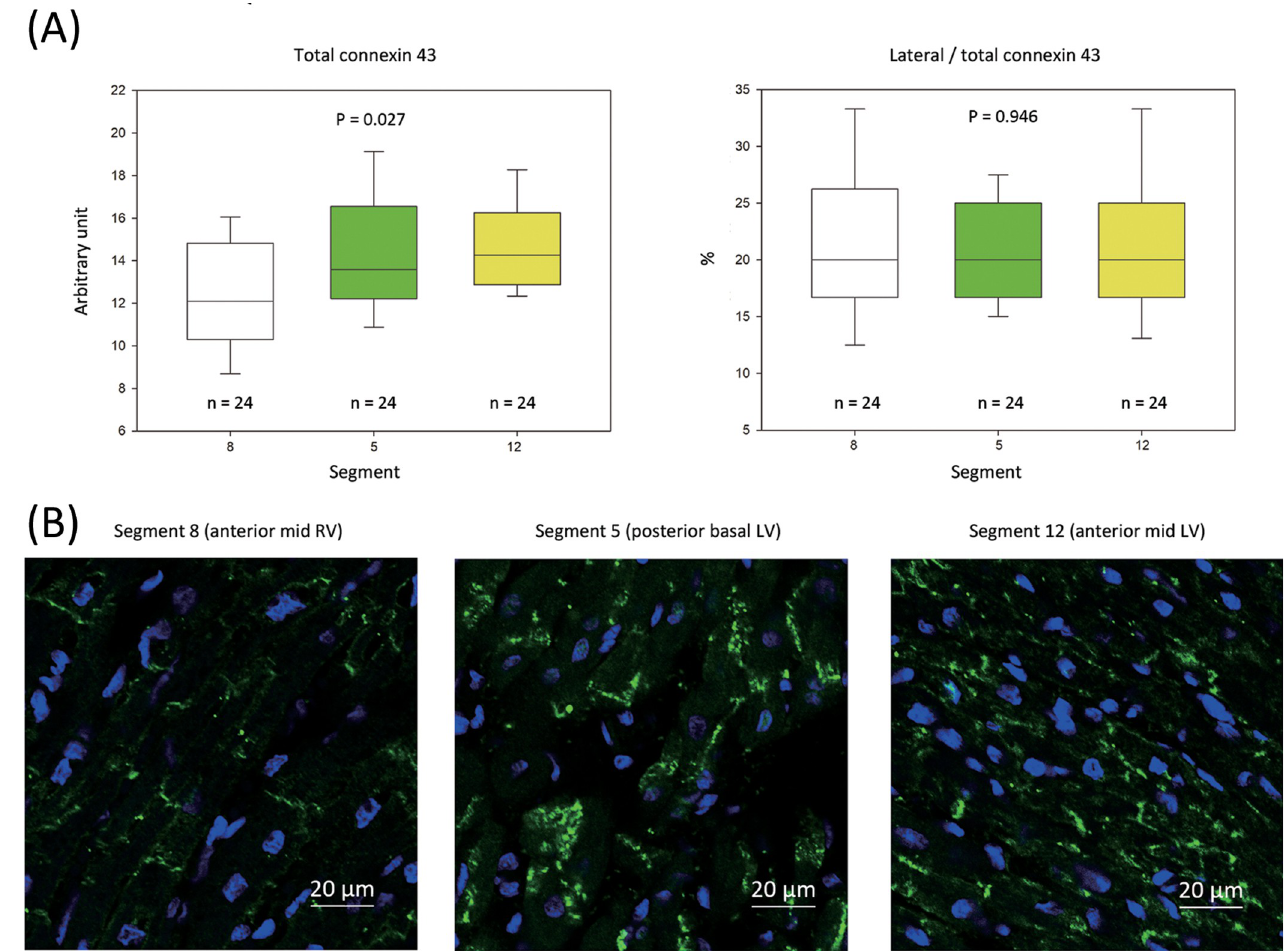
Fig 6. Regional differences in the connexin 43 expression during TH and amiodarone treatment. (A) Left panel: Comparison of the connexin 43 expressions among segment 8 (anterior mid RV wall), segment 5 (posterior basal LV wall), and segment 12 (anterior mid LV wall). The data are presented as box plot. These data were derived from pig 3, pig 4, pig 5, and pig 6 from the protocol I. Right panel: Comparison of the connexin 43 lateralization among segment 8 (anterior mid RV wall), segment 5 (posterior basal LV wall), and segment 12 (anterior mid LV wall). The data are presented as box plot. These data were derived from pig 3, pig 4, pig 5, and pig 6 from the protocol I. (6 slides from each segment of each pig) The parameters between the three segments were compared using one-way ANOVA. (B) Presentative fluorescent images of the connexin 43 expressions. Left panel: anterior mid RV (segment 8 of pig 6); middle panel: posterior basal LV (segment 5 of pig 5); right panel: anterior mid LV (segment 12 of pig 4). Green fluorescence: connexin 43; blue fluorescence: 4,6-diamidino-2-phenylindole for nucleus. BT: baseline temperature; LV = left ventricle; RV = right ventricle; RVP = right ventricular pacing; TH = therapeutic